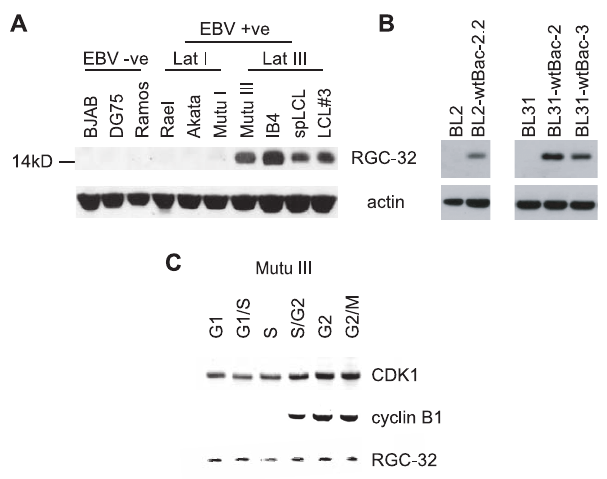
Figure 1. RGC-32 protein is selectively expressed in EBV infected latency III cells. (A) Western blot analysis of RGC-32 protein expression in a panel of EBV negative and positive B-cell-lines. Blots were stripped and re-probed with anti-actin antibodies as a loading control (B) Western blot analysis of RGC-32 protein expression in two EBV negative BL cell-lines (BL2 and BL31) infected with recombinant wild-type EBV bacmids [15]. (C) Western blot analysis of RGC-32 protein expression in Mutu III cell-cycle fractions obtained by centrifugal elutriation. Blots were probed for CDK1 and cyclin B1 as controls for cell-cycle phases. Cell-cycle phases were confirmed by Flow cytometry (Figure S1).